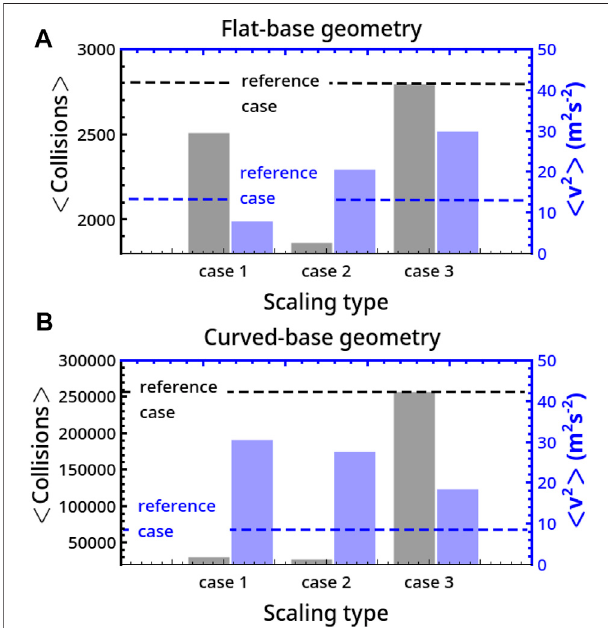
FIGURE 8 | Comparison of the average number of collisions on the basis, 〈 Collisions 〉 , and mean squared velocity per collision, 〈 v 2 〉 , for different scaling (cases 1, 2, and 3) of the system size. Panel A and B describe results for fl at- and curved-base geometries.